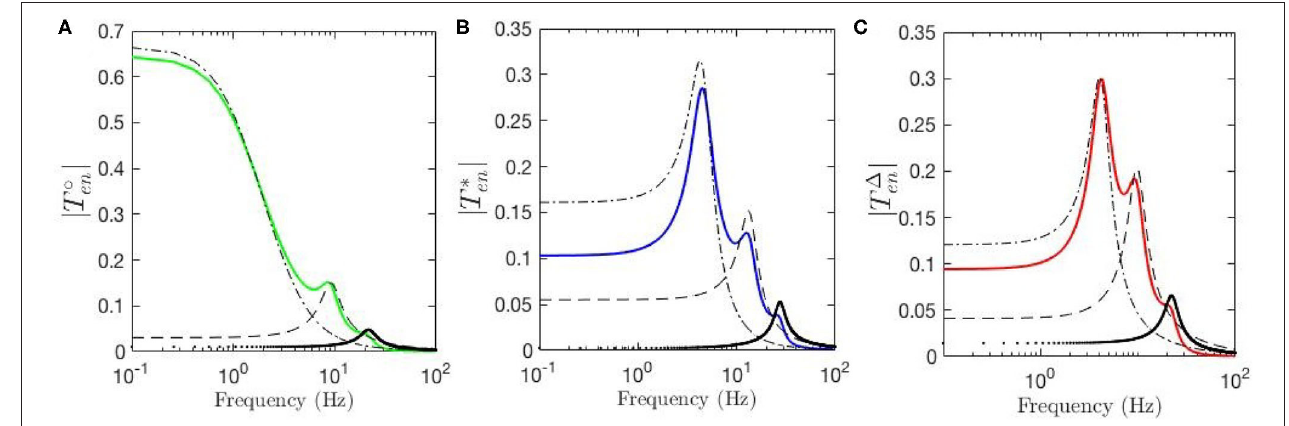
FIGURE 8 | Magnitudes of the transfer functions and their retrieved filters vs. frequency. Here, ℓ represents the low-frequency filter without oscillations, the dash-dot lines represent theta filters, the dashed lines represent alpha filters, and the dotted lines represent beta filters. (A) T ◦ en for fixed-gain resting EEG parameters. (B) T * en for fixed-gain ERP parameters of Kerr et al. (2008). (C) T 1 en for the gain-modulated model with initial resting EEG